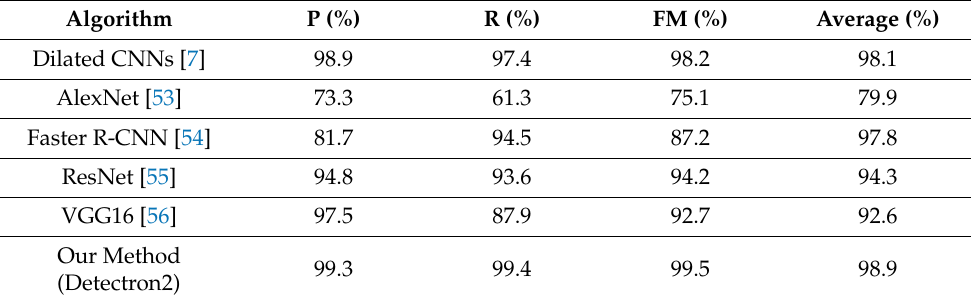
Table 7. Quantitative results of fire detection.